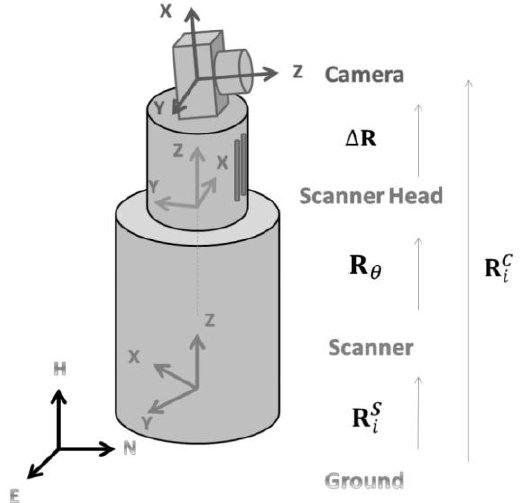
Figure 2. Relationships among the camera, scanner and reference/ground coordinate systems. Each coordinate system is linked via the rotation matrices shown on the right-side of the